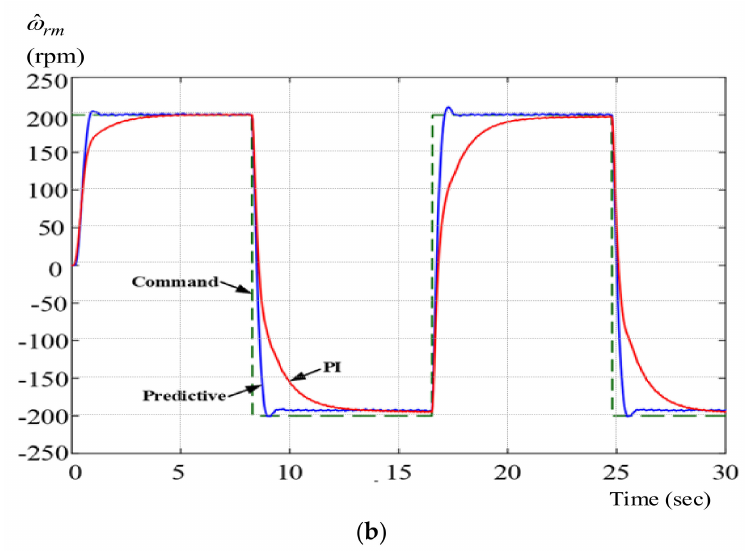
Figure 13. Square-wave tracking responses using di ff erent controllers. ( a ) Simulated; ( b ) measured.